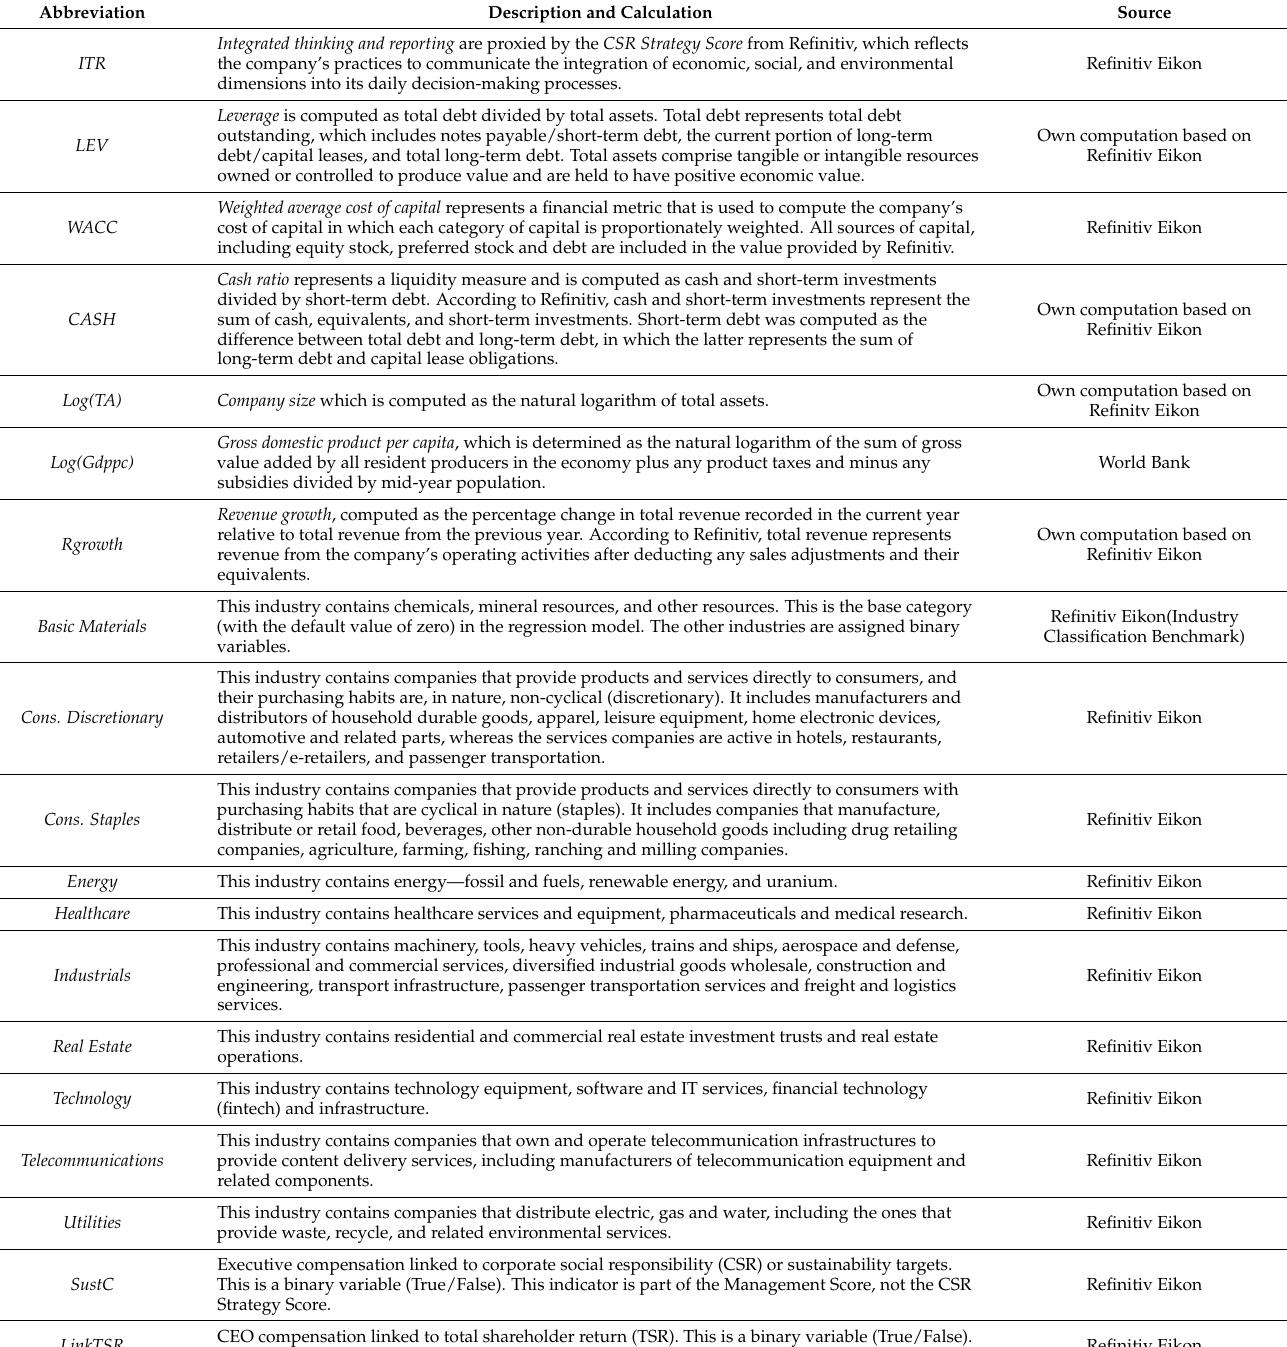
Table 1. Variable